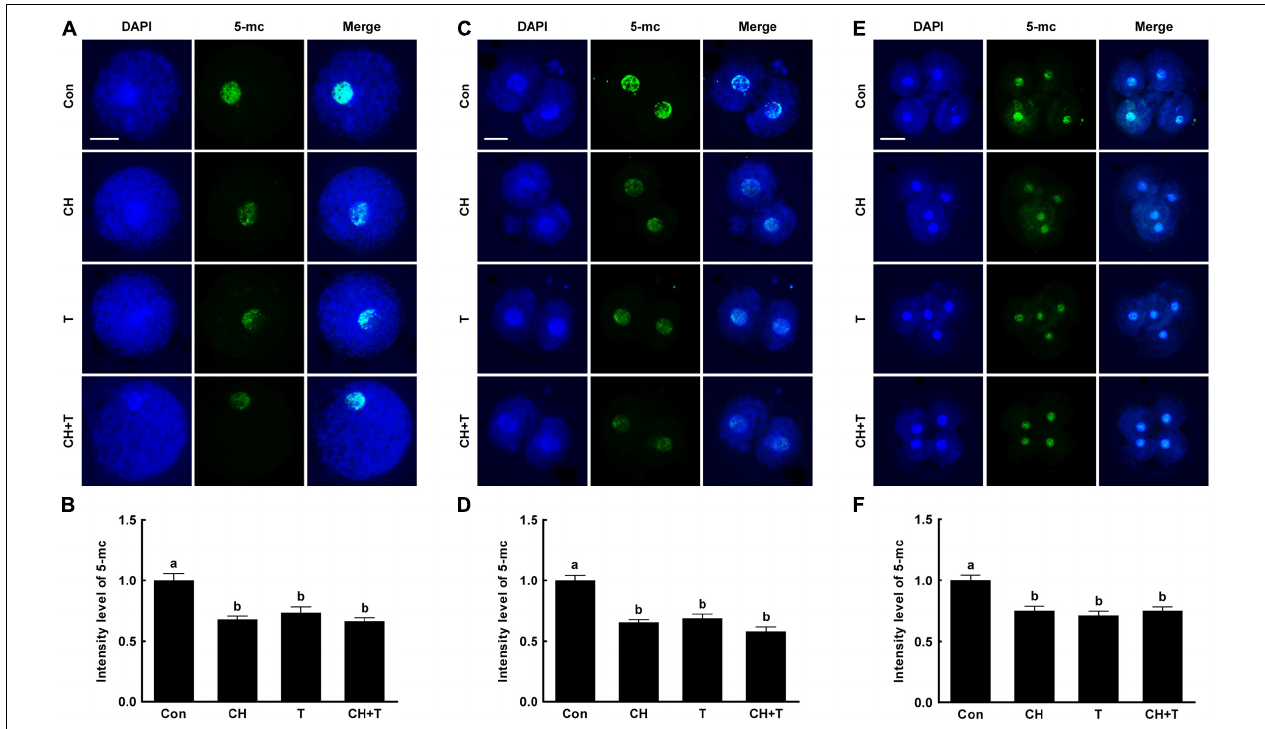
FIGURE 5 | Effects of chaetocin, TSA, and the combination on global DNA methylation in porcine SCNT embryos. (A) Representative immunofluorescent images of 5-methylcytosine (5-mc) at the pronuclear stage. Green and blue fluorescence indicate 5-mc and nuclei, respectively. Bar = 50 µ m. (B) Quantification of fluorescence intensity at the pronuclear stage ( n = 20 per group). (C) Representative immunofluorescent images of 5-mc at the two-cell stage. Green and blue fluorescence indicate 5-mc and nuclei, respectively. Bar = 50 µ m. (D) Quantification of fluorescence intensity at the two-cell stage ( n = 20 per group). (E) Representative immunofluorescent images of 5-mc at the four-cell stage. Green and blue fluorescence indicate 5-mc and nuclei, respectively. Bar = 50 µ m. (F) Quantification of fluorescence intensity at the four-cell stage ( n = 18 per group). The data are from three independent experiments and are means ± SEM. Values with different superscripts differ significantly ( P < 0.05). Con, control; CH, chaetocin; T,